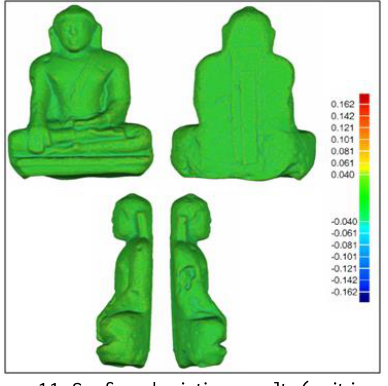
Figure 11. Surface deviation results (unit in mm)